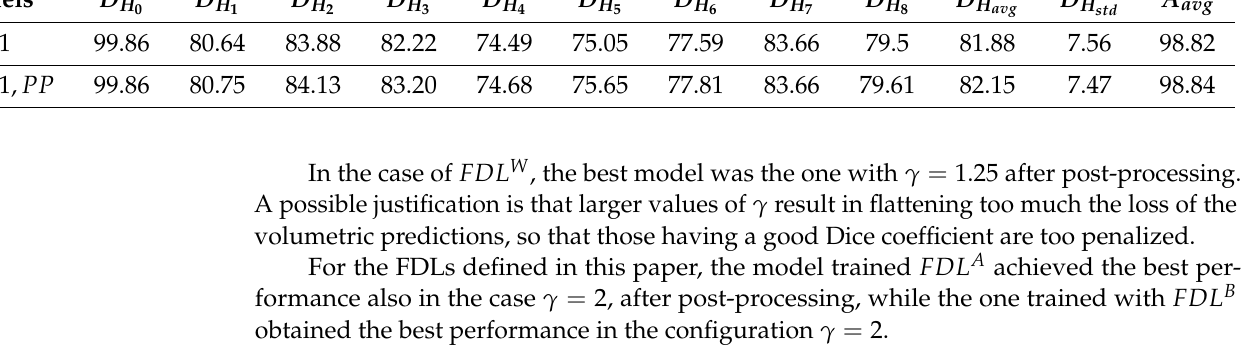
. The average accuracy is t